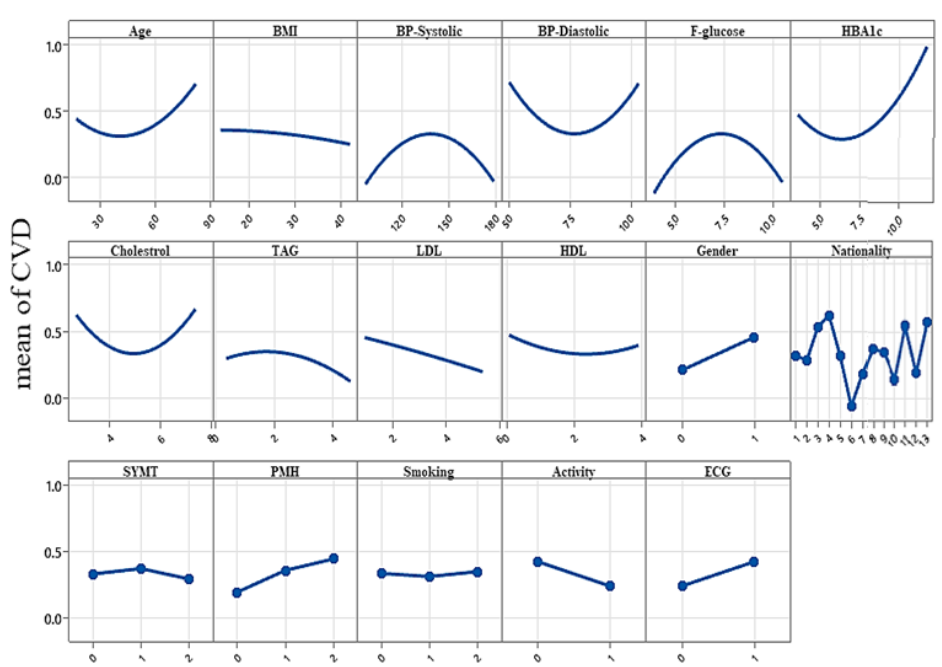
Figure 19. Plot of main effects for significant parameters on a CVD; see abbreviations in